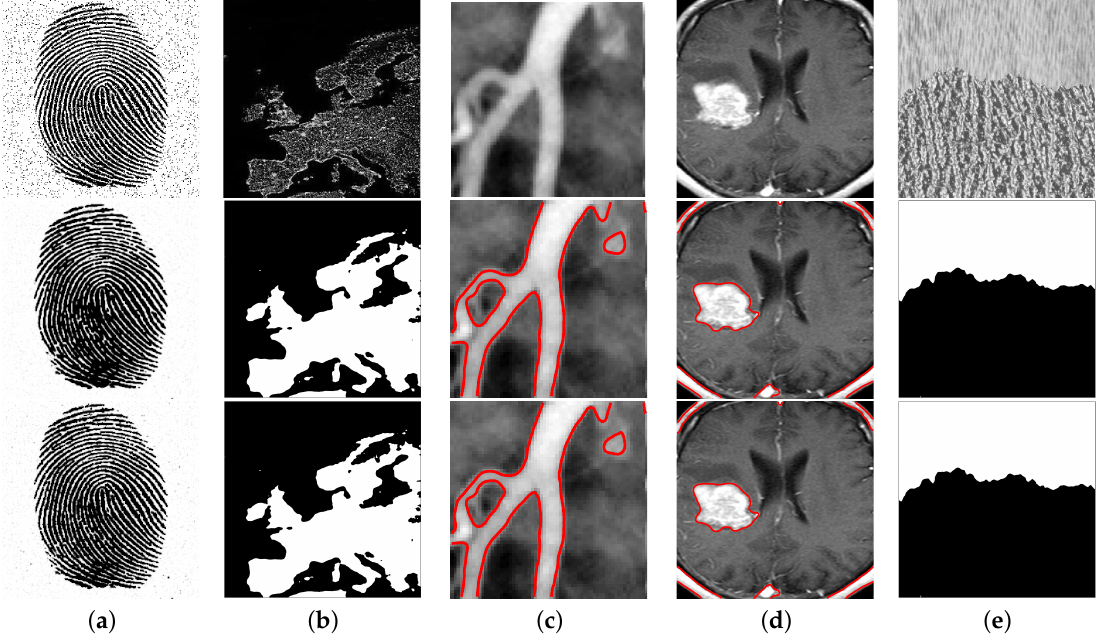
Figure 11. Various image segmentation: ( a ) fingerprint, ( b ) Europe night-lights, ( c ) blood vessel, ( d ) brain MRI, and ( e ) texture images. From top to bottom, original images, the segmented results using our proposed method and previous method in [13].